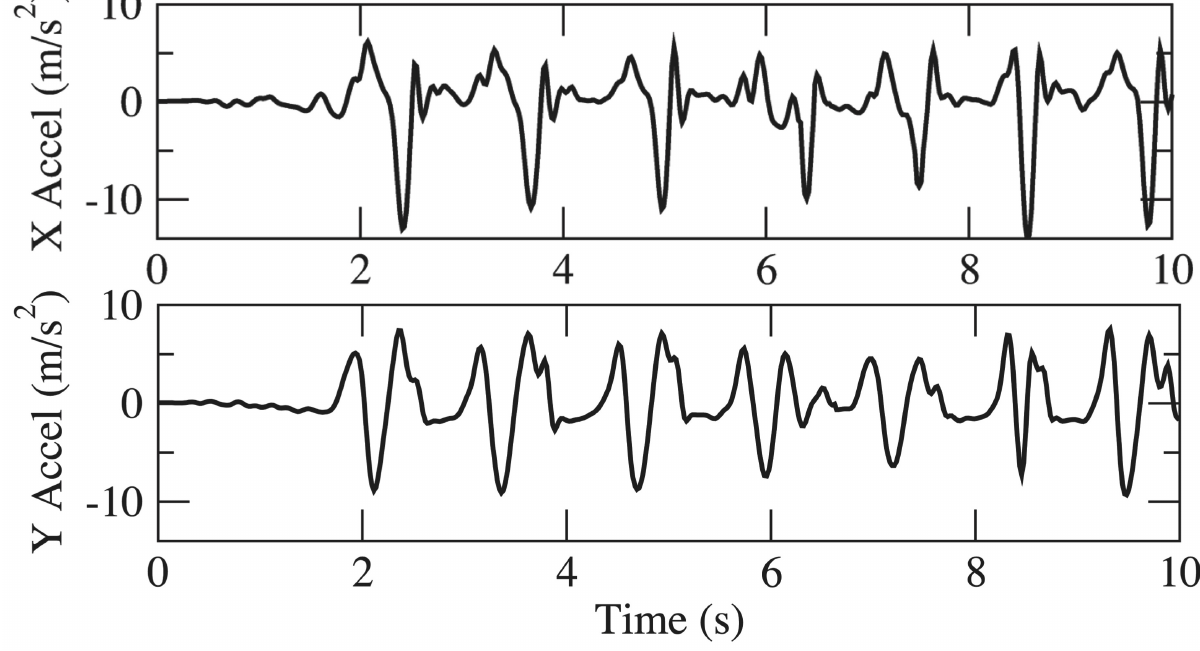
Figure 7. Acceleration in walking, Unified Parkinson’s Disease Rating Scale (UPDRS) gait score =